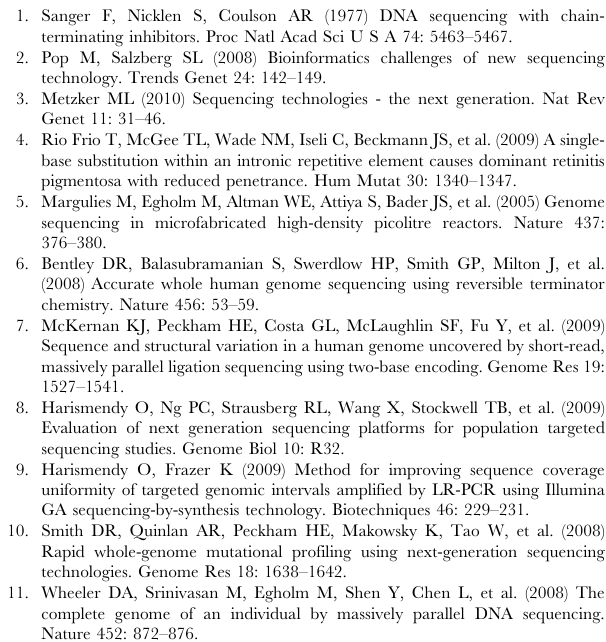
Figure S1 Distributions of read lengths from the three platforms tested. The output generated from short-read platforms consists in reads having the same length: Illumina GA generated only reads of 34 nt and ABI SOLiD generated mostly reads of 50 nt, with only a small fraction of them (0.4%) having shorter lengths. Figure S2 Similarity plot of the region analyzed. The VNTRs within the TPFT and PRPF31 sequences are indicated by arrows. Vertical lines (corresponding horizontal lines are omitted) indicate the position of SNPs rs35705606 and rs2668836 at coordinates 13,761 and 14,098, respectively, that were under-detected by short read platforms. Table S1 Coverage of individual amplicons.